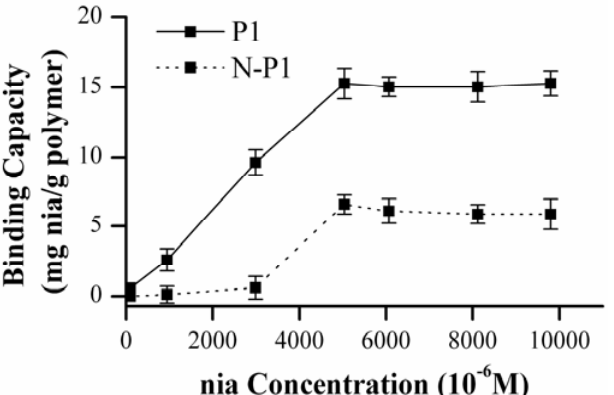
Figure 5. Binding capacity in CHCl N-P1 versus nia